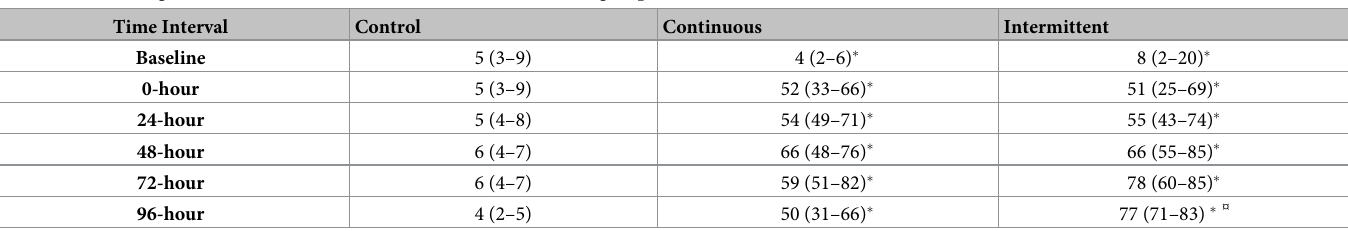
Table 1. RV to PA gradient in the control, continuous, and intermittent